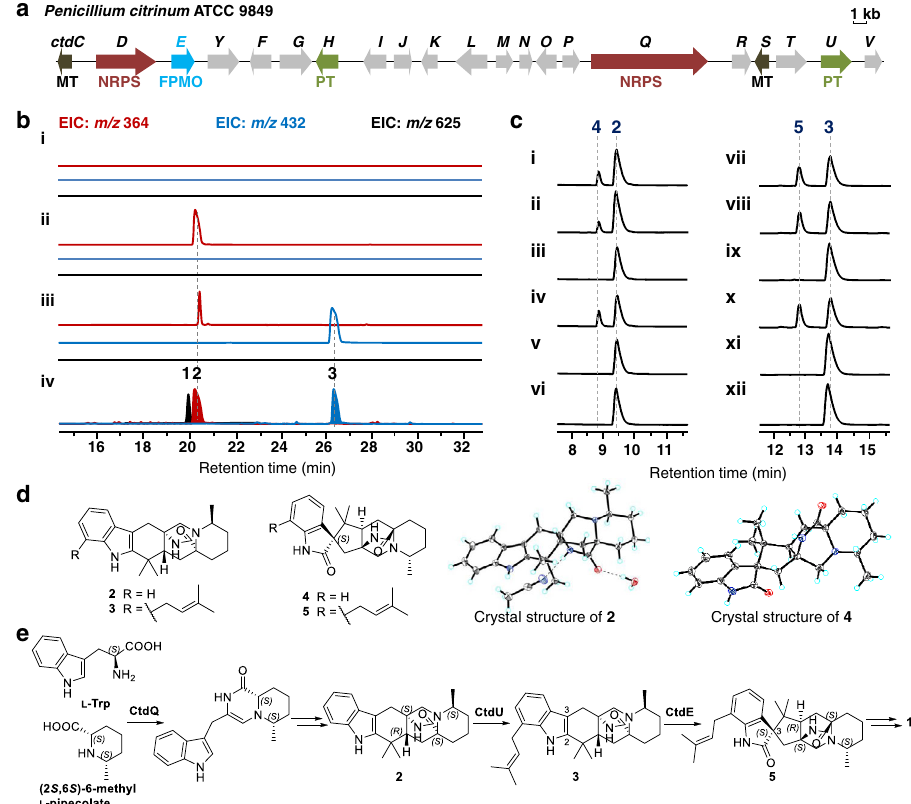
Fig. 2 Functional characterization of CtdE and the proposed biosynthetic pathway. a Putative gene cluster for 1 biosynthesis in P. citrinum . b LCMS analysis (extracted ion chromatogram, EIC) of 1 production in P. citrinum wild-type (WT) and ctd mutants: (i) Δ ctdQ , (ii) Δ ctdU , (iii) Δ ctdE , (iv) standards of compounds 1 – 3 . EIC traces of m/z 364 (red), m/z 432 (blue), and m/z 625 (black) are in different colors. c In vitro assays of CtdE. (i) 2 + CtdE + NADH + FAD, (ii) 2 + CtdE + NADH, (iii) 2 + CtdE + FAD, (iv) 2 + CtdE + NADPH + FAD, (v) 2 + NADPH + FAD, (vi) 2 + NADH + FAD, (vii) 3 + CtdE + NADH + FAD, (viii) 3 + CtdE + NADH, (ix) 3 + CtdE + FAD, (x) 3 + CtdE + NADPH + FAD, (xi) 3 + NADH + FAD, and (xii) 3 + NADPH + FAD. d Chemical structures of 2 – 5 , and X-ray crystal structures of 2 and 4 . e Proposed biosynthetic pathway of 1 . (LCMS elution methods for ctd mutants extract and in vitro assays are different, see details in